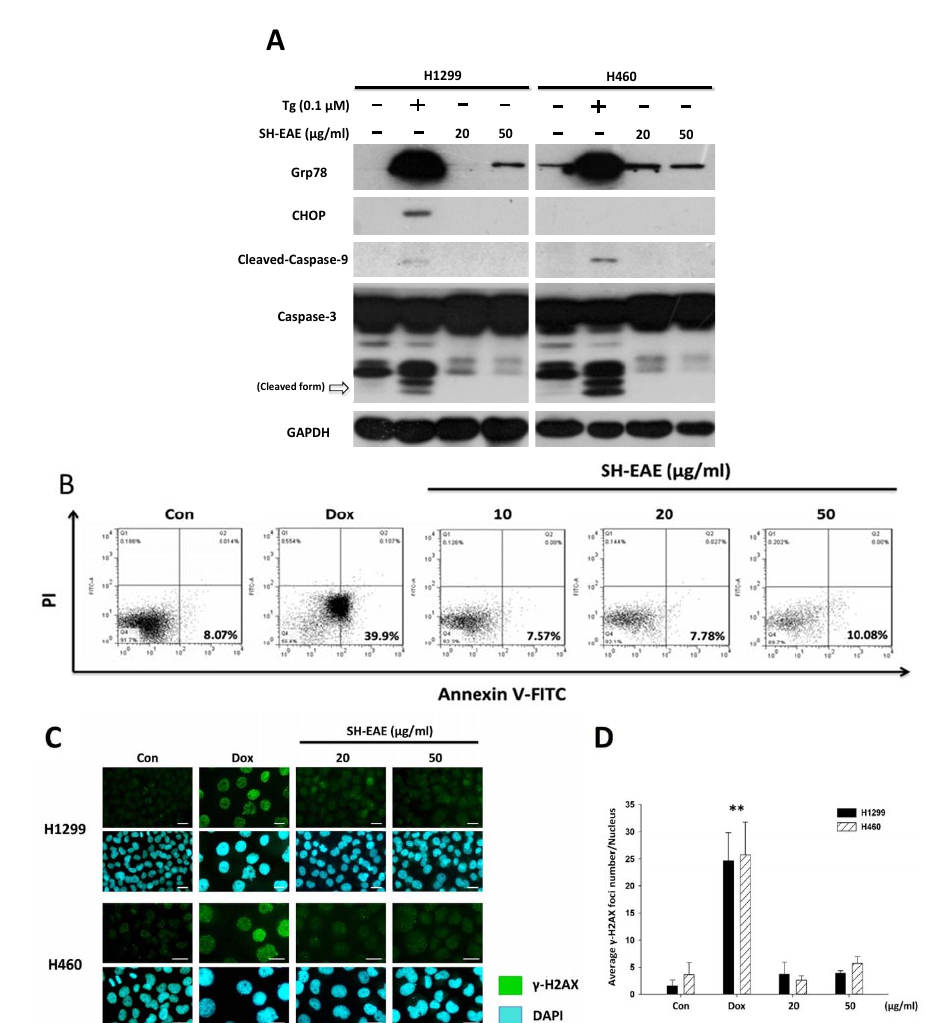
Figure 7. SH ‐ EAE regulates UPR signaling but does not induce apoptosis. ( A ) Western blotting demonstrates relative protein levels of UPR components, including Grp78, CHOP, and proapoptotic proteins, such as caspase ‐ 9 and caspase ‐ 3, in NSCLC cells. Different from the Tg treatment. The increased levels of Grp78 in the SH ‐ EAE treatment groups were obviously lower than the Tg group, and SH ‐ EAE did not induce CHOP expression compared to Tg. The cleaved (active) form of caspase ‐ 3 and ‐ 9 were only induced in the Tg treatment. GAPDH serves as loading control. One of the two independent experiments is shown. ( B ) Annexin V ‐ PI staining was performed to analyze apoptotic cell populations. 2 × 10 5 cells were seeded into a six ‐ well plate and treated with different concentrations (10, 20, and 50 μ g/mL) and Dox (2 μ M) for 48 h. Data are presented as dot plots (Annexin V ‐ FITC on the x ‐ axis; PI on the y ‐ axis). The cell numbers in the four quadrants represent the percentage of viable (lower left), necrotic (upper left), early apoptotic (lower right), and late apoptotic (upper right) cells determined by using a BD Accuri™ C6 flow cytometer. Data are representative of three independent experiments. ( C ) A gallery of representative images of γ ‐ H2AX foci was shown. Both H1299 and H460 cells were treated with SH ‐ EAE (20 and 50 μ g/mL) and Dox (2 μ M) for 48 h. Cells were fixed and stained by immunofluorescence with anti ‐γ‐ H2AX (FITC, green). Nuclei were counterstained with DAPI. Representative images of H1299 and H460 cells obtained from at least three independent experiments for each condition are shown. ■ γ‐ H2AX; ■ DAPI. Scale bar indicates 50 μ m. ( D ) Quantification of the numbers of γ‐ H2AX foci per nucleus after treatment with Dox or SH ‐ EAE. Dox served as a positive control for DNA damage. The average numbers of γ‐ H2AX foci per cells treated with SH ‐ EAE (20 and 50 μ g/mL) were insignificant at 48 h as compared with untreated control cells. More than 50 cells were randomly analyzed using a software “ImageJ”. Data represent the mean ± SD of three independent experiments. (** p < 0.001). 2.8. SH ‐ EAE Antagonizes the Induction of CHOP Expression by Tg SH ‐ EAE acting through the inhibition of UPR signaling was confirmed by immunoblot analysis using pretreatment of H1299 cells with SH ‐ EAE, being further treated with Tg, which served as an ER stress inducer. The protein expression of C/EBP homologous protein (CHOP) as an important transcription factor activated by the PERK pathway, was absent in untreated H1299 cells or cells treated with SH ‐ EAE alone (Figure 8), and it was induced significantly in H1299 cells treated with 0.1 μ M Tg alone. However, pretreatment with H1299 cells with 20 and 50 μ g/mL SH ‐ EAE, gradually inhibited the induction of Grp78 and CHOP expression evoked by Tg (Figure 8). Besides, our data also demonstrated that pretreatment with 20 and 50 μ g/mL SH ‐ EAE suppressed Tg ‐ induced cleavage of caspase ‐ 3 and ‐ 9 in a dose dependent manner (Figure 8). These findings suggest that SH ‐ EAE has an antagonistic effect on UPR signaling outputs in NSCLC cells. Figure 8. SH ‐ EAE abrogated the Tg ‐ mediated induction of Grp78 and CHOP expression. H1299 cells were pretreated with SH ‐ EAE for 10 h and further treated with Tg for another 12 h. Protein lysates were subjected to SDS ‐ PAGE followed by immunoblotting using antibodies against Grp78, CHOP, cleaved ‐ caspase ‐ 9 and caspase ‐ 3. H1299 cells pretreated with 20 and 50 μ g/mL SH ‐ EAE were significantly inhibited by Tg ‐ induced CHOP expression. α‐ tubulin served as the loading control. 2.9. SH ‐ EAE Attenuated the Angiogenesis in Zebrafish Model Recently, IRE ‐ 1 α and PERK have been postulated to play a role in the promotion of tumor angiogenesis [10,28,29]. To examine whether SH ‐ EAE that dramatically suppressed the protein levels of IRE ‐ 1 α and PERK can influence the angiogenesis in vivo, we tested the anti ‐ angiogenic effects of SH ‐ EAE with a zebrafish model. Zebrafish larvae derived from transgenic line Tg(fli1:EGFP) with fluorescent blood vessels were grown in embryo water (0.2 g/L of Instant Ocean Salt in distilled water) at 28 °C in 24 ‐ well plates with 10 larvae per well. Beginning at 10 h post fertilization (hpf), zebrafish larvae were exposed to 20 μ g/mL of SH ‐ EAE and assessed at 24 hpf. Treatment with SH ‐ EAE significantly inhibited intersegmental vessels (ISVs) formation (Figure 9A,B). Continuous